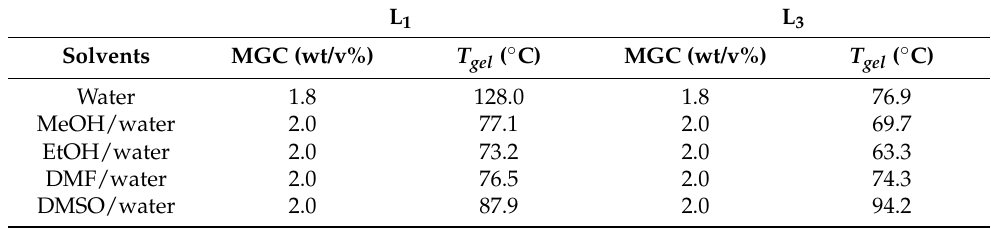
Table 1. Minimum gelator concentration and T gel values of L 1 and L 3 (2.0 wt/v%) in water and aqueous mixtures.